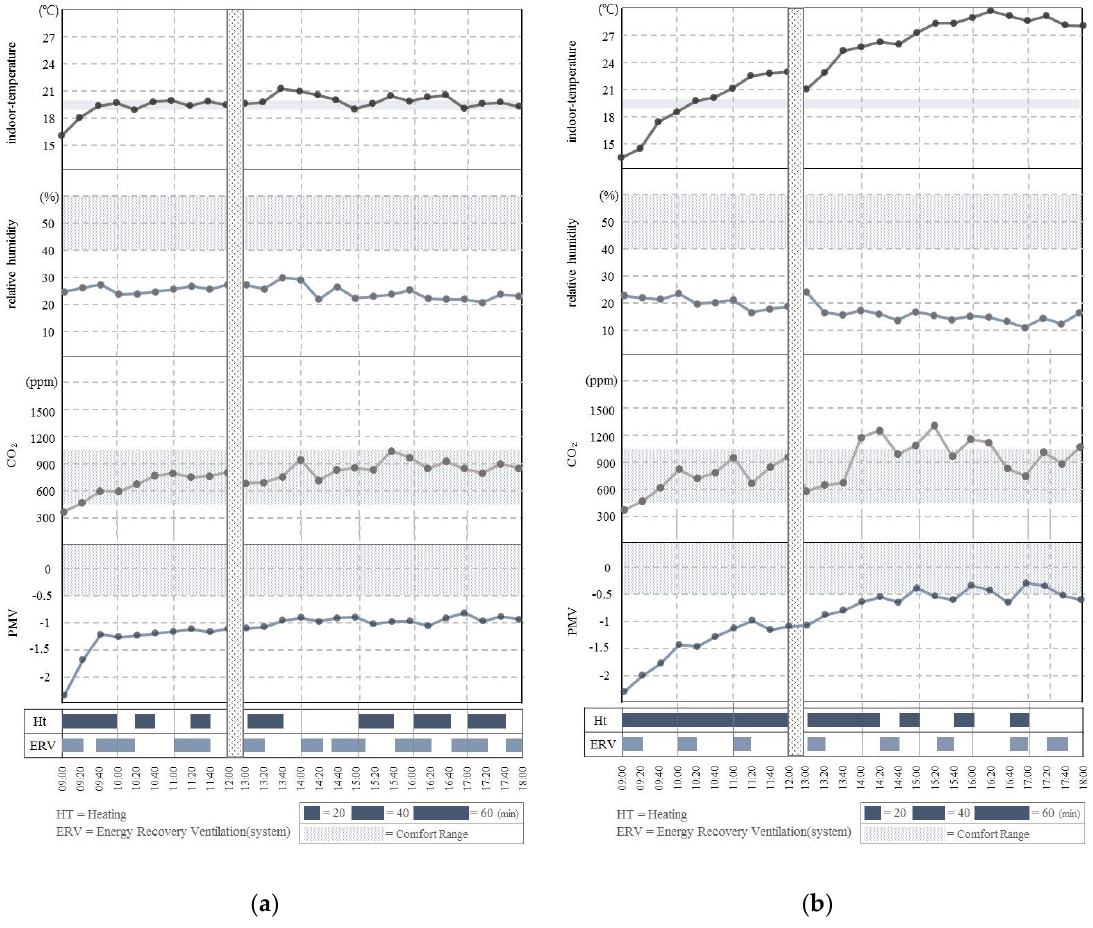
Figure 4. Results graph of the experimental group: ( a ) results graph of the experimental group A (temperature and humidity index); ( b ) results graph of the experimental group B (PMV index)